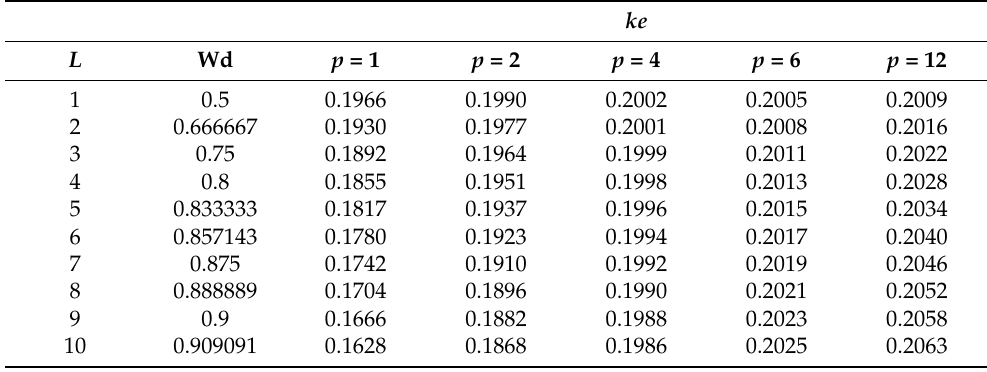
Table 3. The dependence of the equity cost ( ke ) on the leverage level ( L ) of a three-year-old company for advance profit tax payments with frequencies of p = 1, 2, 4, 6 and 12.